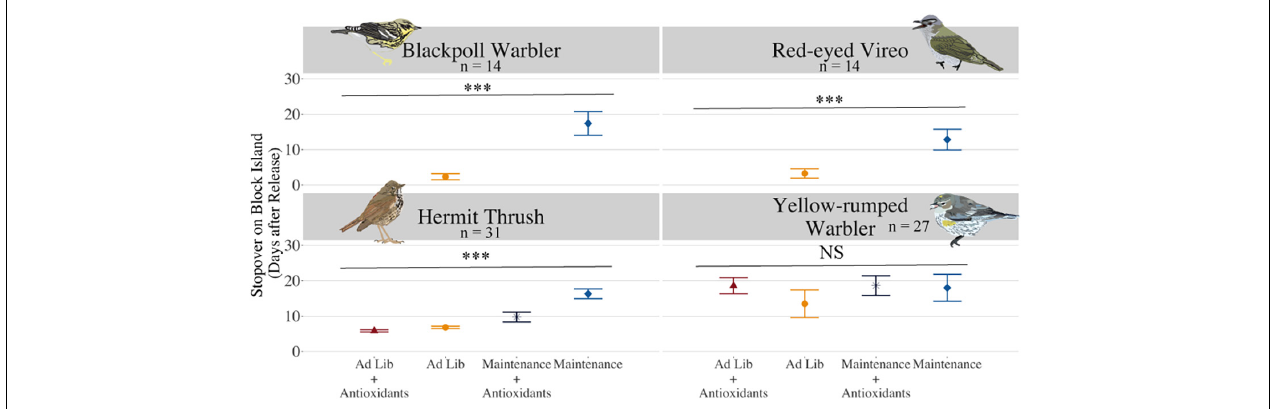
FIGURE 5 | Stopover duration (days on Block Island after release from captivity) for individuals fed ad lib without supplemental polyphenols (gold circles) or with supplemental polyphenols (dark red triangles), or at maintenance levels without supplemental polyphenols (light blue diamonds), or with supplemental polyphenols (dark blue stars). “***” indicates that P < 0.001.